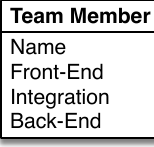
Figure 5. Team member